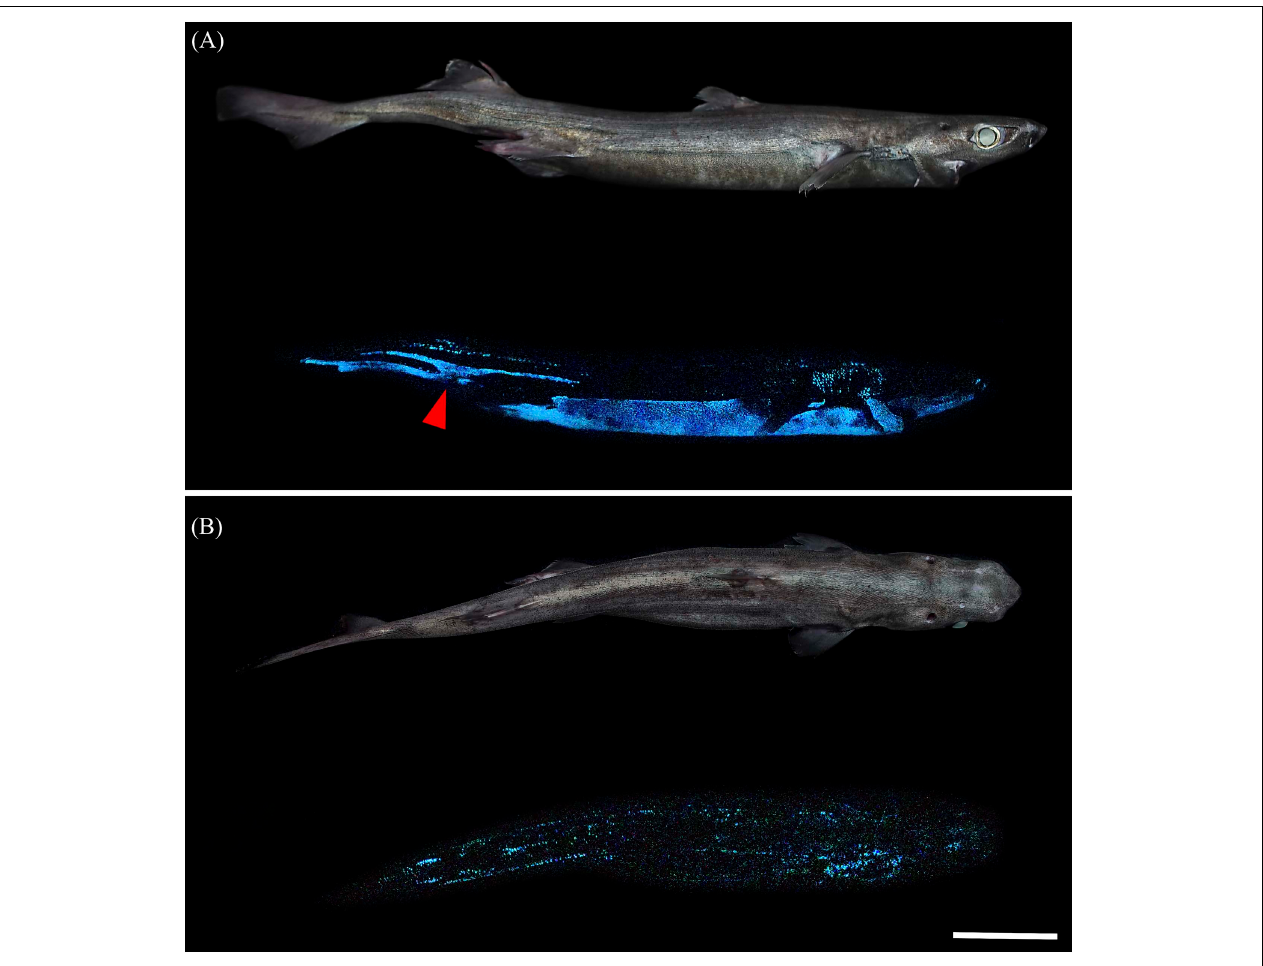
FIGURE 4 | Lateral and dorsal luminescent pattern of Etmopterus lucifer . (A) Lateral daylight view and luminescent pattern. The species-specific flank mark is indicated by a red arrowhead (B) dorsal daylight view and luminescent pattern with specific luminous lines. Scale bar: 10